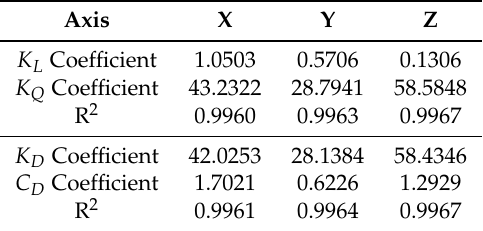
Table 5. Values Obtained through the CFD Simulation.